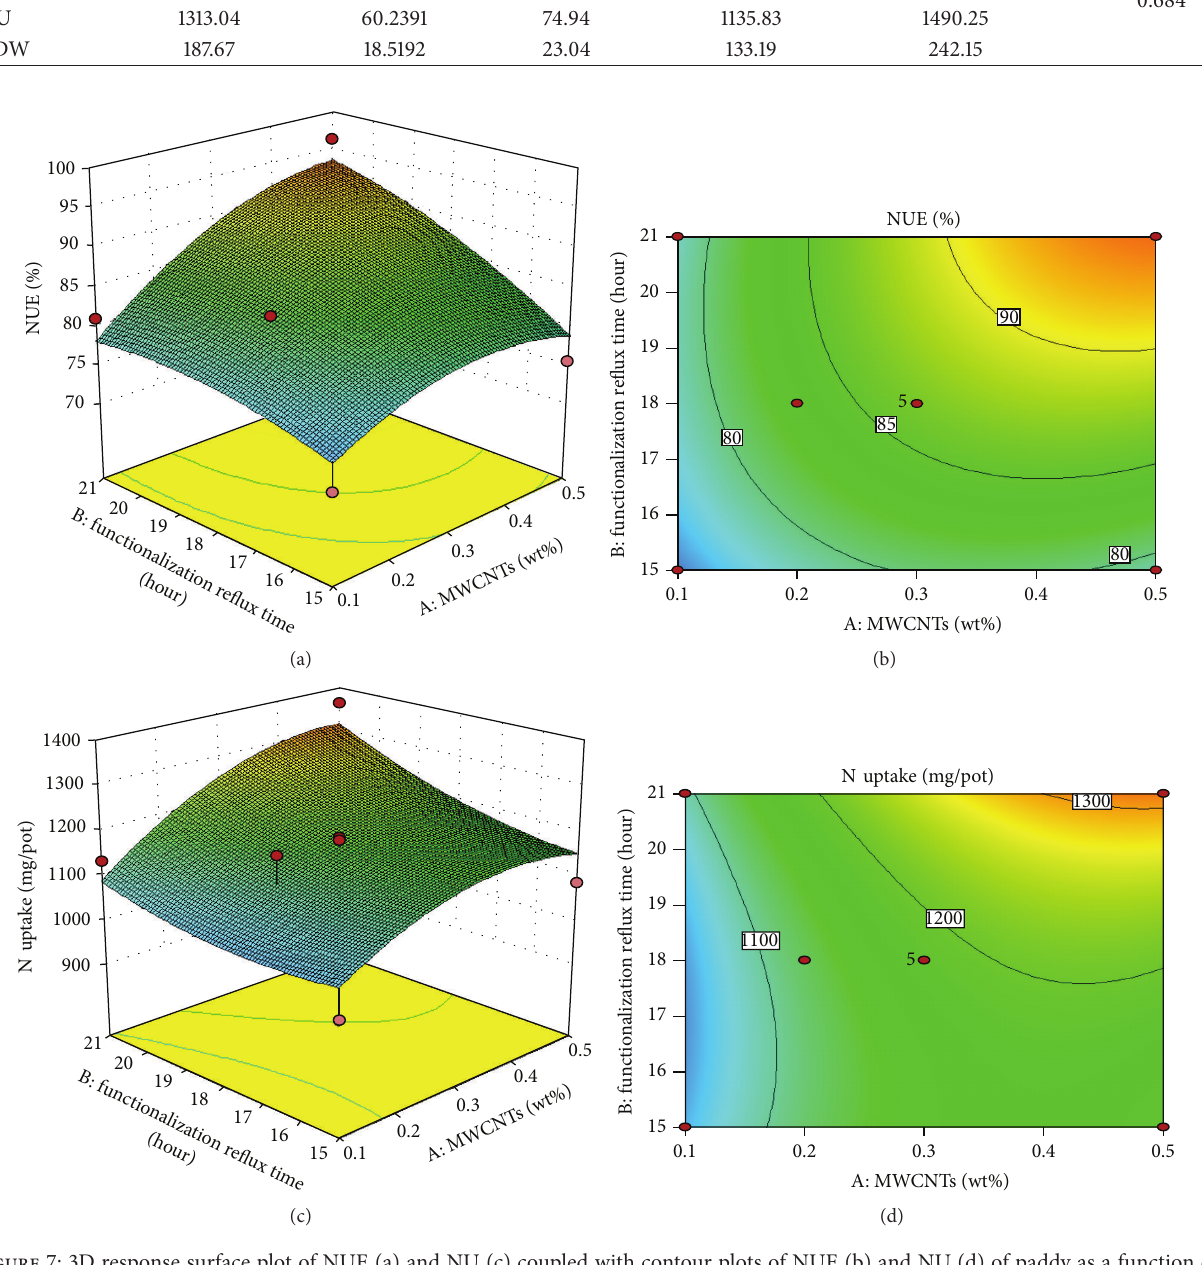
Figure 7: 3D response surface plot of NUE (a) and NU (c) coupled with contour plots of NUE (b) and NU (d) of paddy as a function of f-MWCNTs (%) and functionalization reflux time